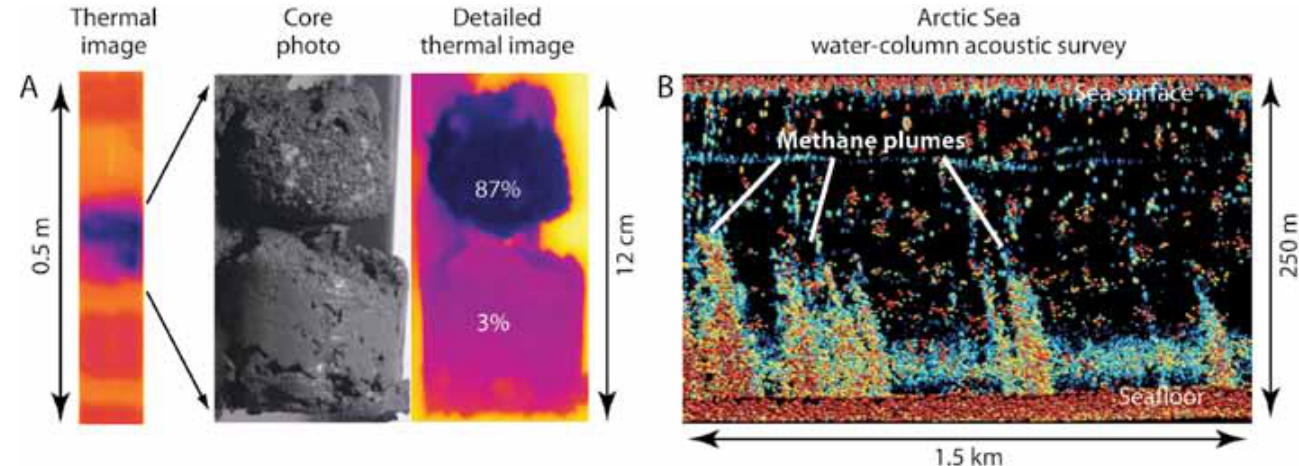
figure 5.4. new tools are being developed to assess the distribution of gas hydrate in marine sediments. (a) The panels show how thermal anomalies (detected with an infrared camera) were used to identify areas of hydrate concentration immediately following recovery of core materials. subsamples were collected and analyzed separately to assess the quantity of hydrate present at a centimeter scale, and to understand what controls its distribution. studies such as these are important for determining where and why large movements of gas from subseafloor hydrates to the overlying ocean may occur. from Torres et al. (2008). (B) This water-column acoustic image from the arctic sea shows plumes of methane gas rising from subseafloor hydrate deposits as a result of warming bottom water. drilling, sampling, and experiments can help to resolve why, where, and how rapidly similar processes may occur. from Westbrook et al.